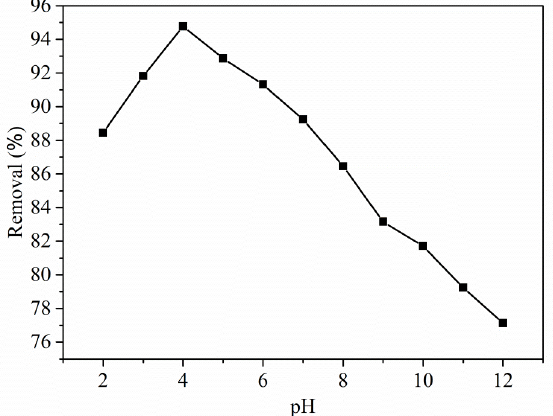
Figure 4. Effect of pH (2–12 range) on the removal efficiency of Cu(I)-PANI composite (the initial concentration, contact time, volume of solution, and amount of adsorbent are 100 mg/L, 90 min, 100 mL, and 0.06 g/L, respectively).